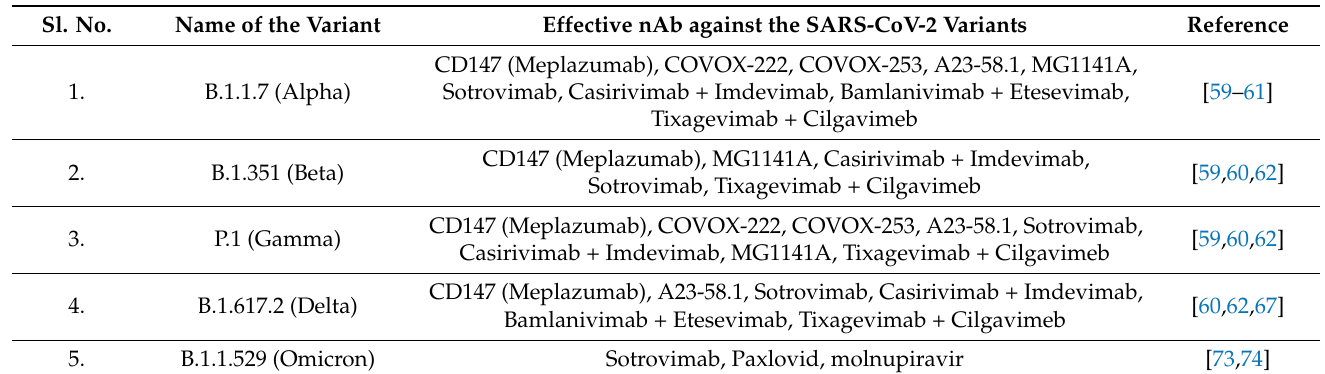
Table 4. Emerging variants of SARS-CoV-2 and nAb, which are in the pre-clinical and clinical